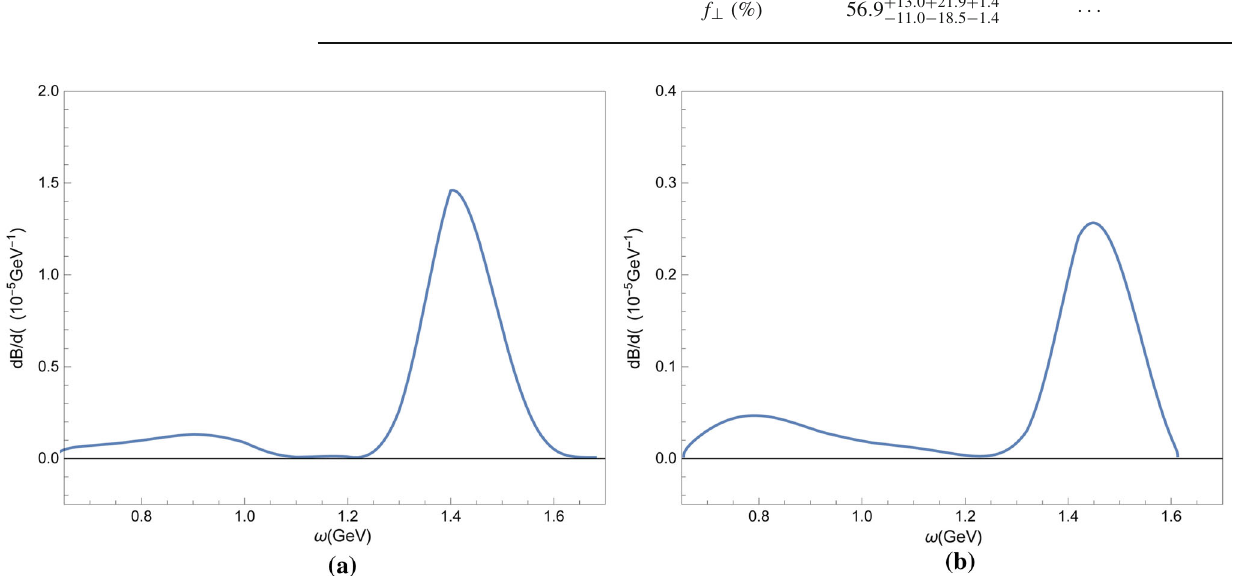
Fig. 2 Differential branching ratios of the S-wave for a B 0 s → ψ( 2 S ) K − π + and b B 0 s → ψ( 1 D ) K − π +